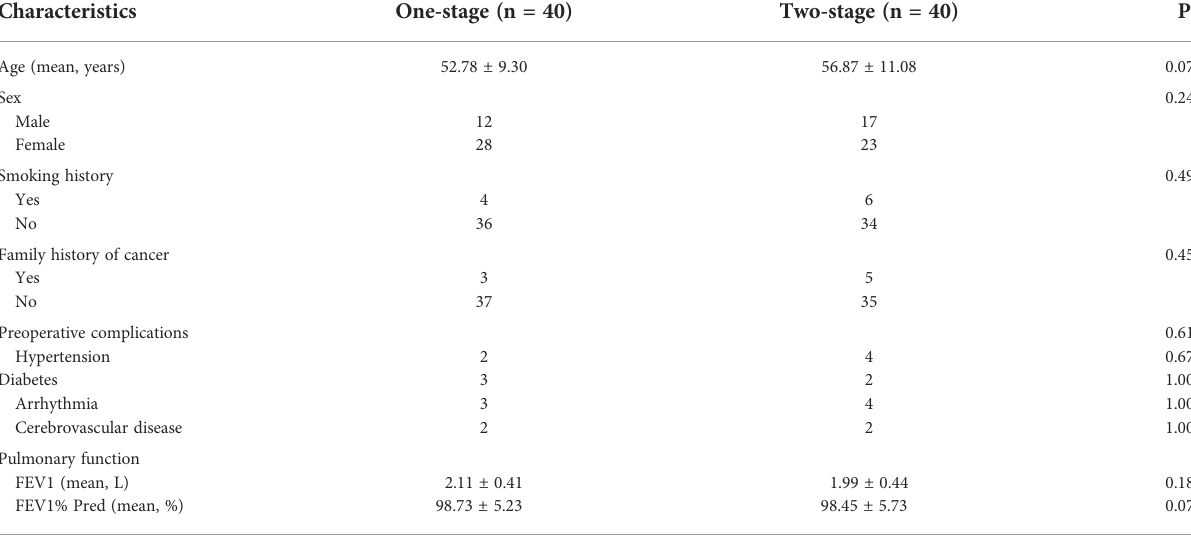
TABLE 1 Comparison of patients ’ clinical characteristics of the two